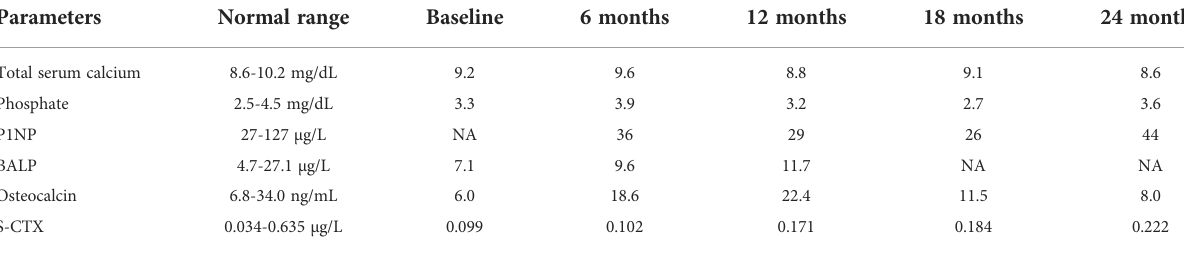
TABLE 1 Biochemical parameters at baseline and during teriparatide